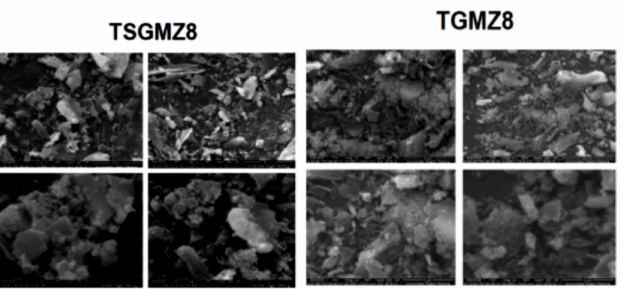
Figure 14. Morphologies of ZnO/CNS (TGMZ8 and TSGMZ8) from sawdust (SG) and rice husk (G) by pyrolysis using microwave at 800 W (code = 8) and ZnCl 2 activator